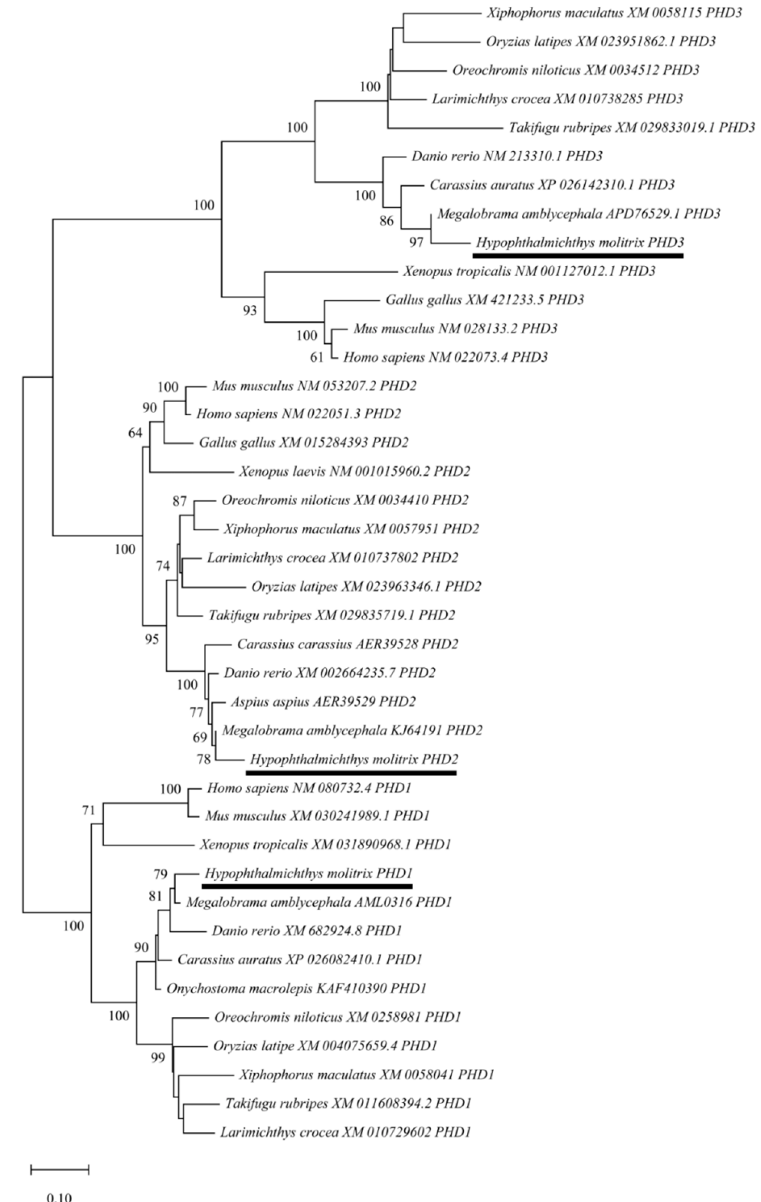
Figure 2. The phylogenetic tree of PHD genes constructed using neighbor-joining method in MEGA X. The bootstrap values mentioned at nodes were derived after 1000 replications. Each sequence is the name of the species and its GenBank accession number. PHDs of H. molitrix are marked by